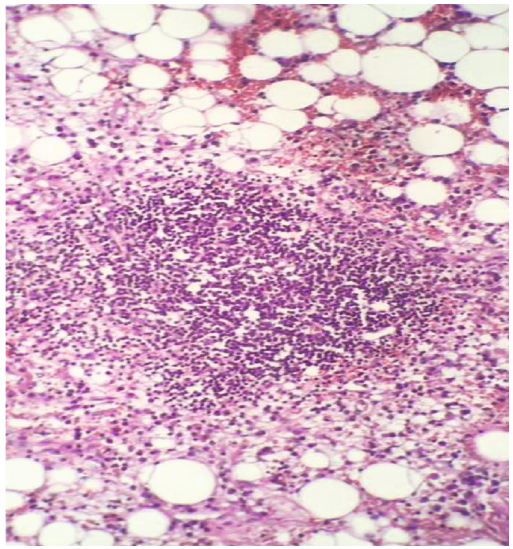
Figure 3: Mature adipose tissue associated with a mixed in fl ammatory in fi ltrate with sparse hematopoietic precursors, lymphocytes, and plasmacytes. Hematoxylin Eosin (HE) 100 X.